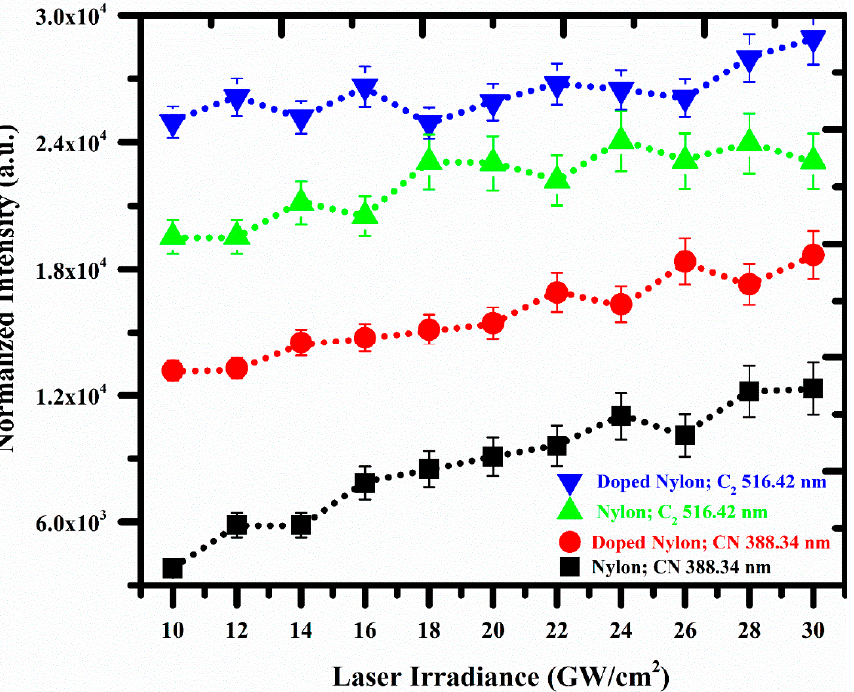
Figure 8 . Normalized intensity of CN and C 2 molecular band at 388.34 nm, and 516.42 nm, respec- tively, as a function of laser irradiance for pure and doped nylon.